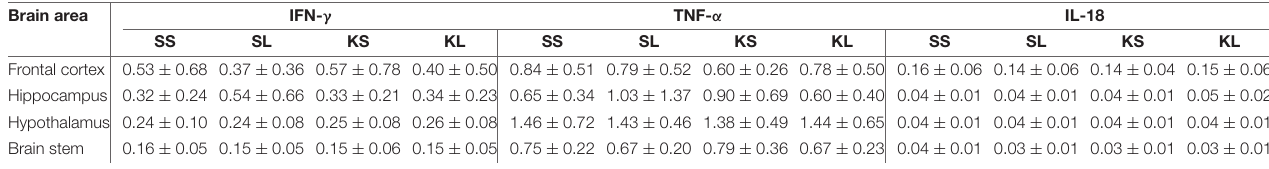
TABLE 4 | Mean ( ± standard deviation) of concentrations (ng g − 1 ) of interferon gamma (IFN- γ ) and interleukin 18 (IL-18) and fluorescence intensity (arbitrary units) of tumor necrosis factor alpha (TNF- α ) in the frontal cortex, hippocampus, hypothalamus, and brain stem of pigs at 72h after injecting the pigs with saline–saline (SS), saline–lipopolysaccharide (LPS) [SL], ketoprofen–saline (KS), and ketoprofen–LPS (KL). Brain area